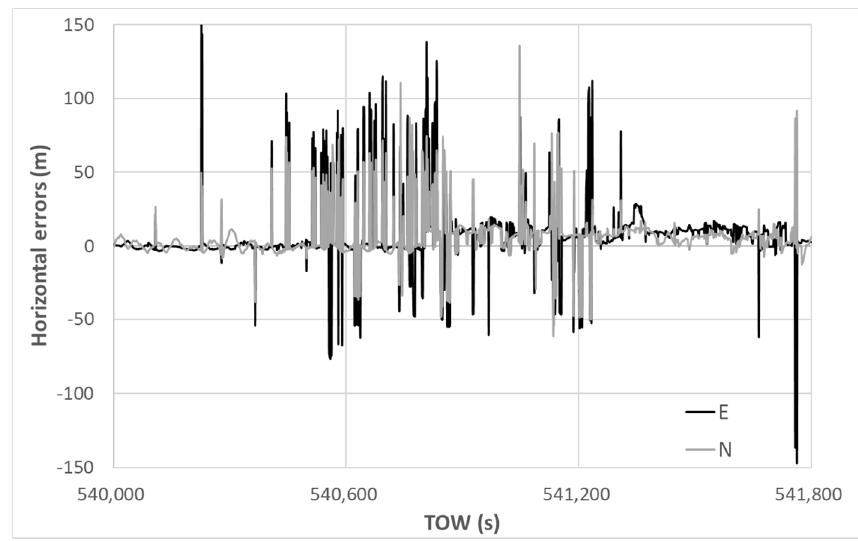
Figure 17 . DGNSS horizontal errors. Figure 17. DGNSS horizontal